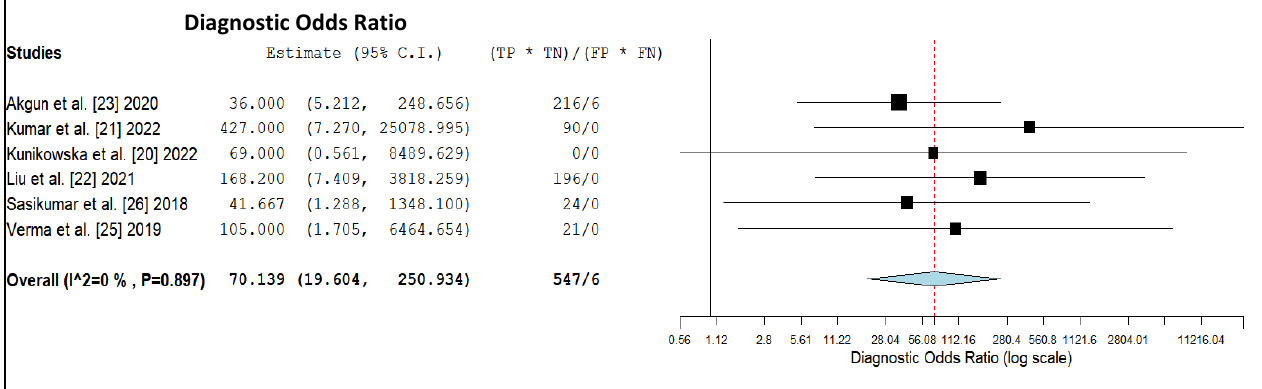
Figure 6. Diagnostic Odds ratio of the index test in high-grade glioma. Legend: 95% C.I. = 95% confidence interval; TP = true positive; TN = true negative; FP = false positive; FN = false negative.